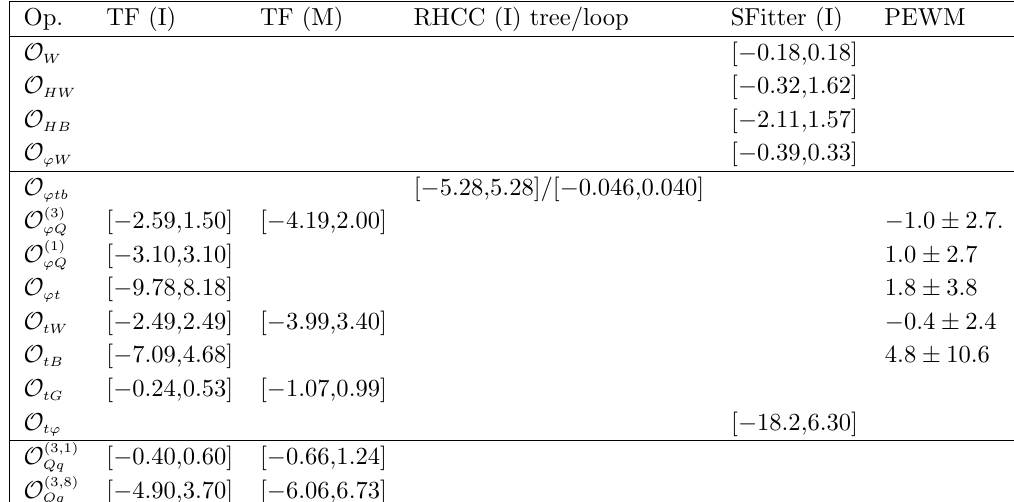
from t (cid:22) t measurements quoted in Qq and and assuming O ’WB O ’D